Question: Provide a one-line summary of what is displayed.
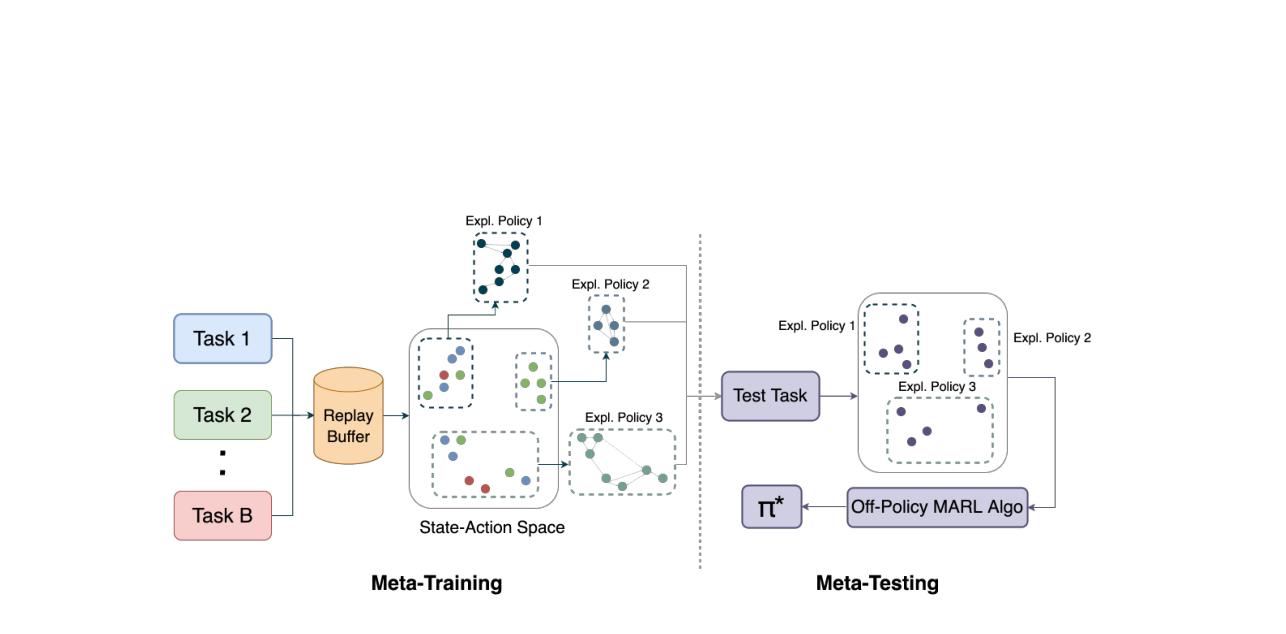
Answer: MESA’s meta-learning framework. In the meta-training stage, MESA learns exploration policies to cover the high- rewarding subspace. In the meta-testing stage, MESA uses the learned exploration policies to assist the learning in an unseen task. Each color corresponds to a diﬀerent task, and the colored points represent the high-rewarding joint state-action pairs collected in that task.